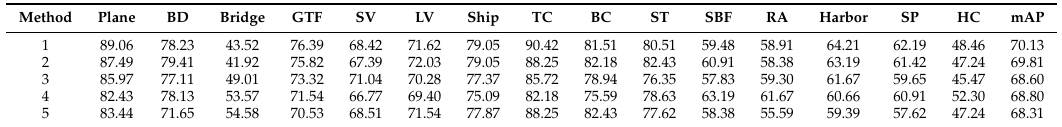
Table 7. mAP for each model. It can be seen from the table that the model obtained by row 1 has the highest overall accuracy.